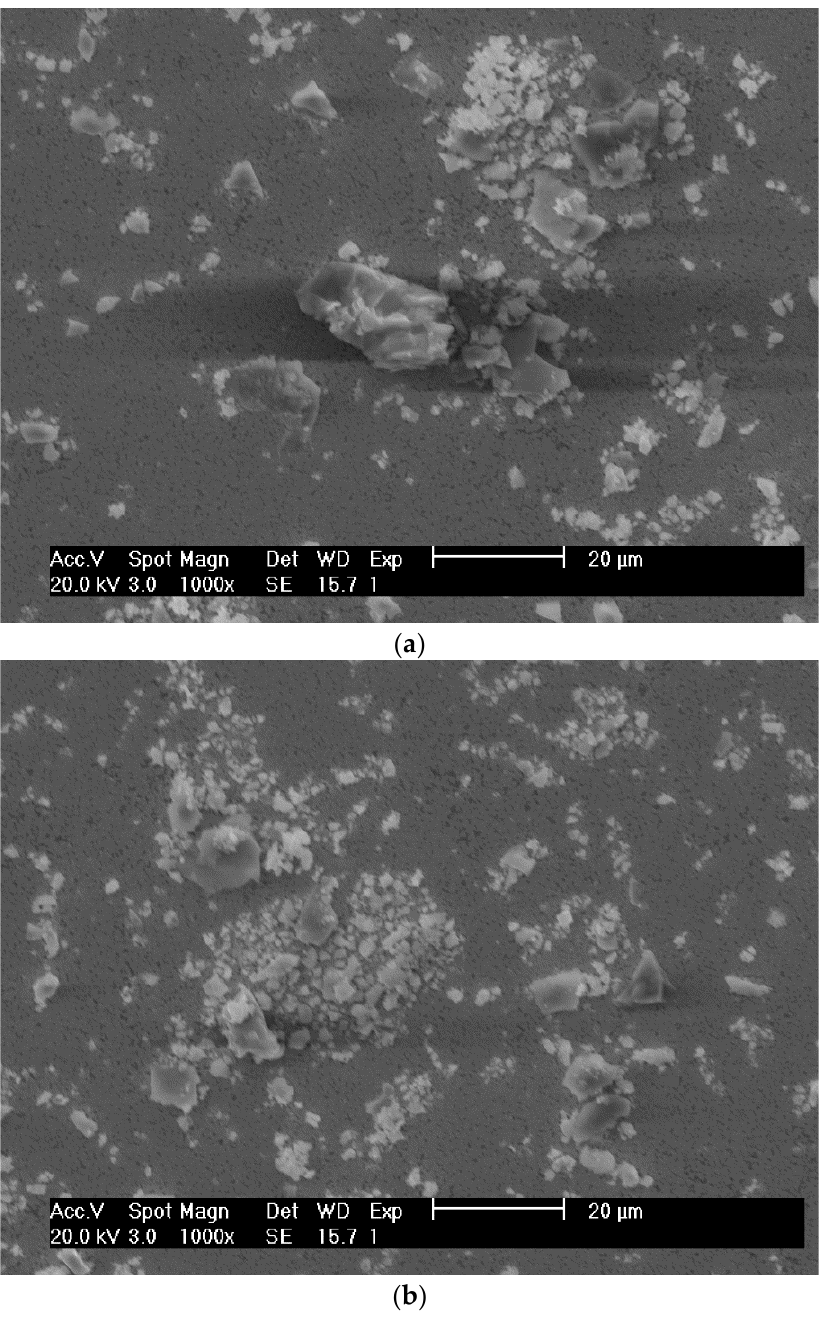
Figure 13. SEM micrographs of debris resulting from the wear of system WC-AISI 304/Al 2 O 3 , corresponding to two different locations on the periphery of the same wear track: ( a ) larger debris, ( b ) smaller debris.